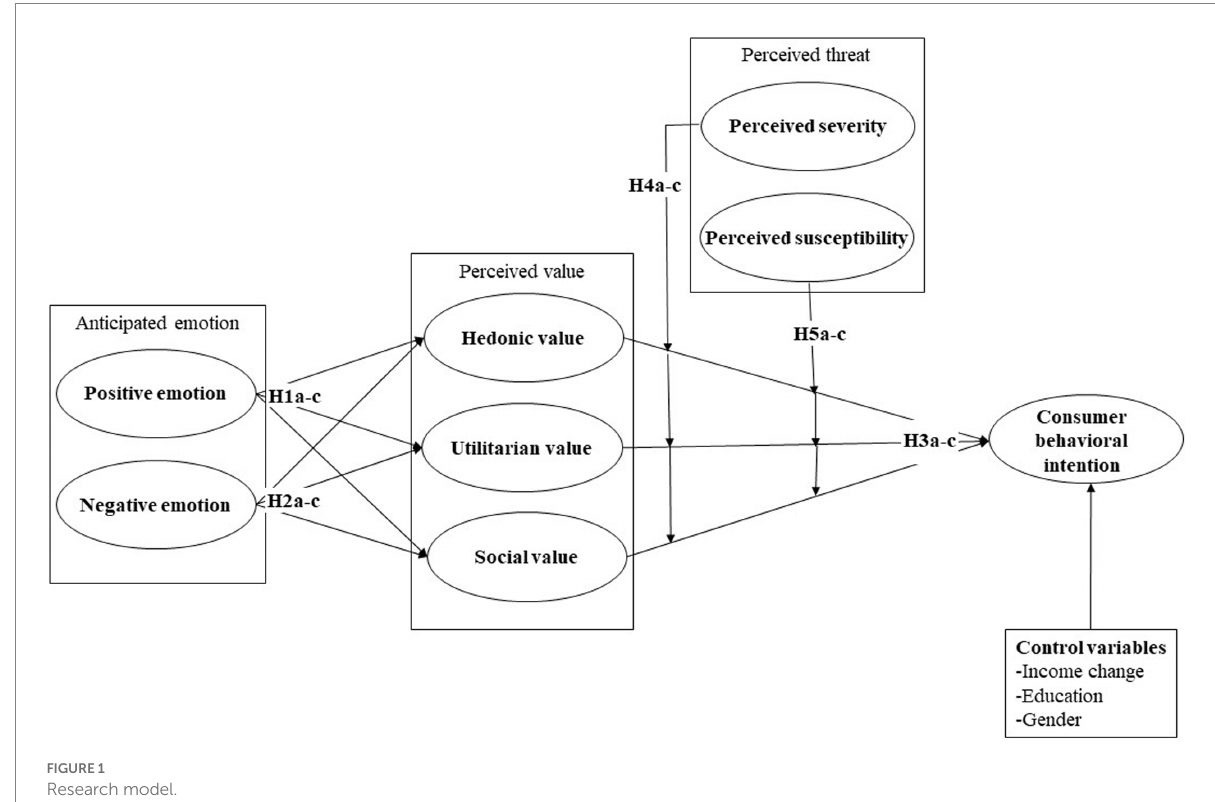
FIGURE 1 Research